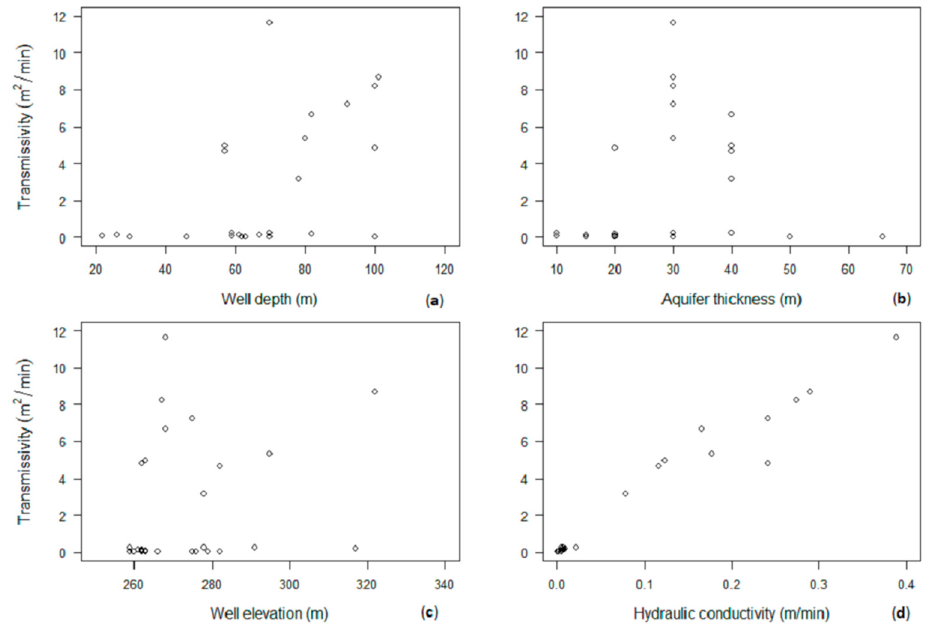
9 of 14 Figure 3. Pumping test-derived T values from 38 boreholes across Kilombero Valley, with the data appearing to be skewed towards lower T values. To explore potential geological controls or systematic patterns in the reported T values,